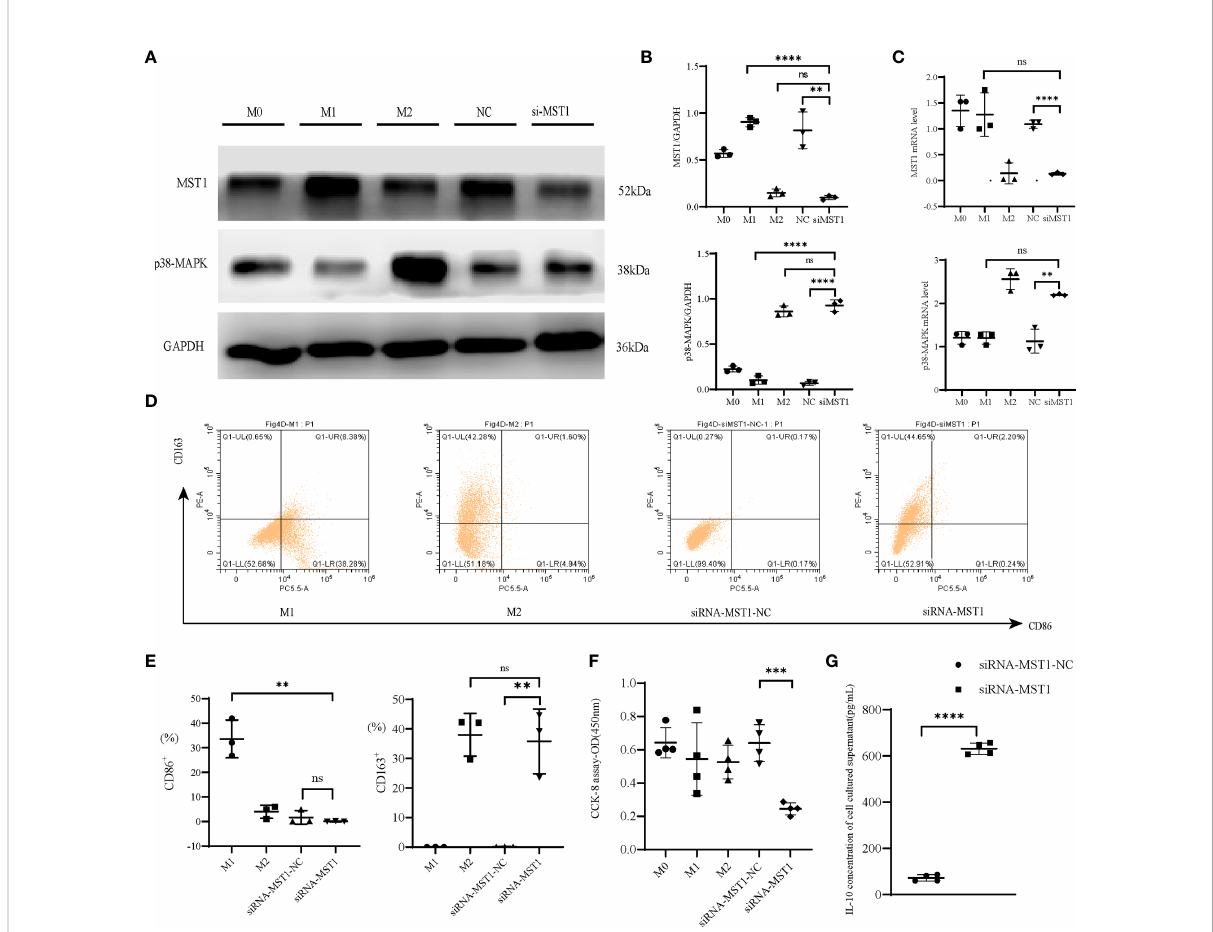
FIGURE 4 MST1 -p38 MAPK regulated the function of macrophages. (A, B) Representative western blot and relative protein expression of MST1 and p38- MAPK after transfecting cells with siRNA- MST1 . (C) The mRNA level of MST1 and p38-MAPK after transfecting cells with siRNA- MST1 by RT-PCR. (D, E) Representative fl ow cytometry to evaluate the polarization state when the expression of MST1 was decreased. (F) Cell viability after transfection. (G) The IL-10 concentration of the culture supernatant after transfection of siRNA- MST1 in THP-1. **P < 0.01, ***P < 0.001, ****P < 0.0001, ns means not statistically signi fi cant. Values represent the mean ± standard